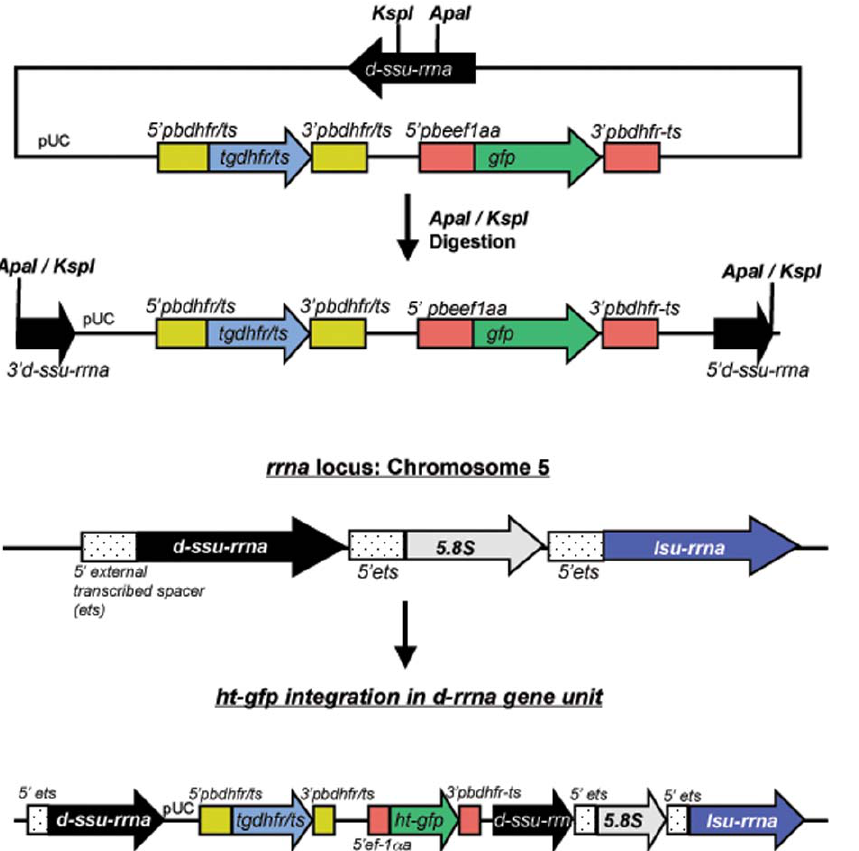
Figure 1. Strategy for integrating pL0016 (HT- or D -GFP) in P.berghei ANKA chromosome 5 by double crossover. The previously described double crossover replacement plasmid pL0016 (pPbGFP CON )[13] was used for cloning of HRPIIminhis.HT.GFP (a truncated HRPII gene containing a minimal histidine sequence, host-targeting motif, and GFP tag) and HRPIIminhis. D .GFP (a truncated HRPII gene containing a minimal histidine sequence, an 11 amino acid alanine-rich replacement of the host-targeting motif, and GFP